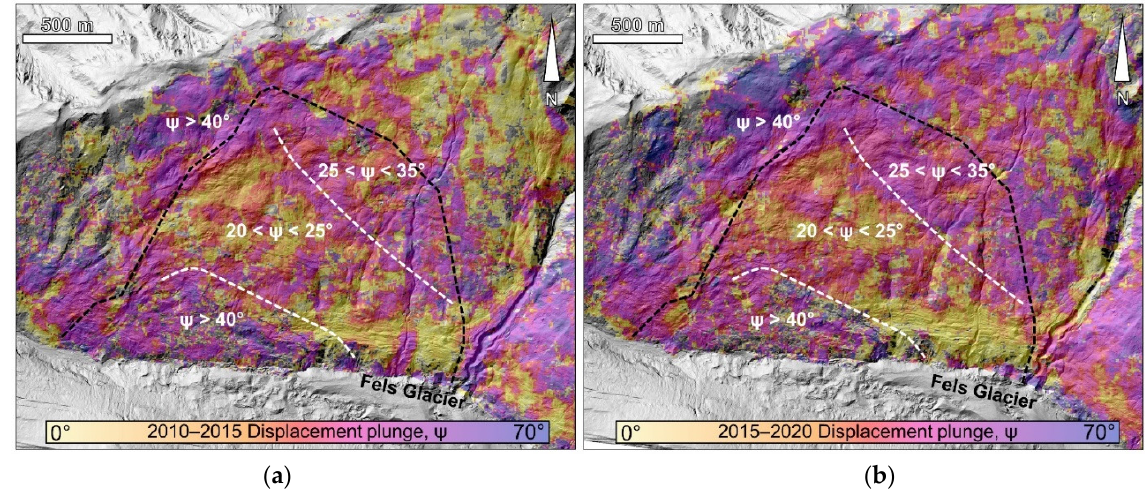
Figure 7. Displacement plunge maps of the Fels landslide overlain on the 2016 ALS hillshade base map. ( a ) Displacement plunge map computed for the 2010–2015 time window. ( b ) Displacement plunge map computed for the 2015–2020 time window. The black dashed line outlines the inferred landslide area, and the white dashed lines mark the approximate boundaries of changes in displacement plunge. Note the relatively high plunge values in the lower slope, corresponding with the fast-moving slope toe. Plunge values decrease in the central part and increase in the upper part of the landslide.